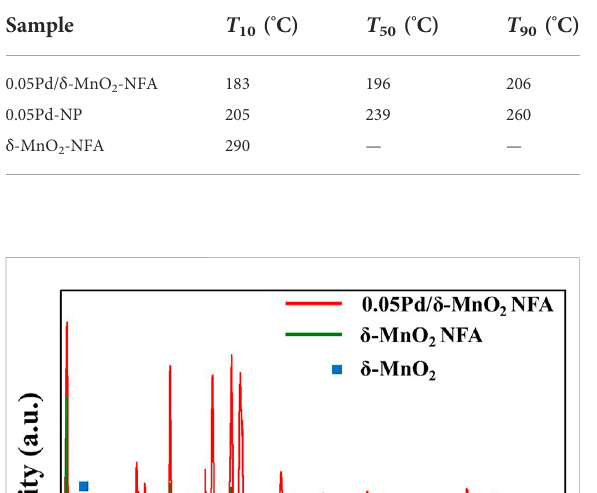
TABLE 2 Values of T 10 , T 50 , and T 90 for o -xylene oxidation.